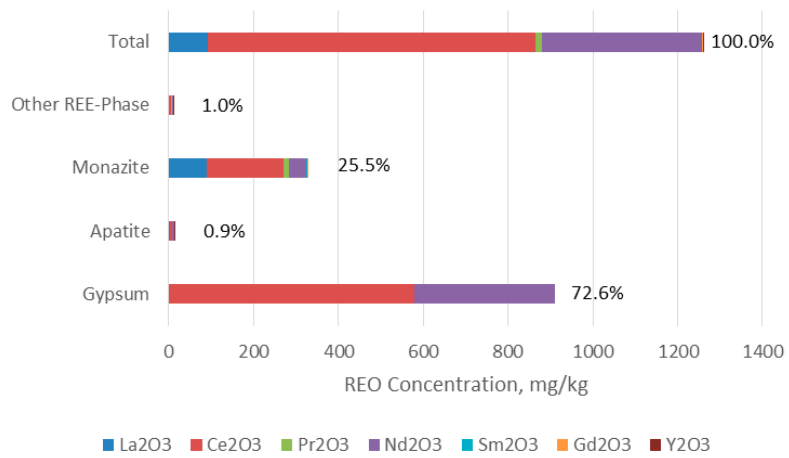
Figure 5. REO concentrations in REE-bearing phases (mg/kg) and recoveries (%)